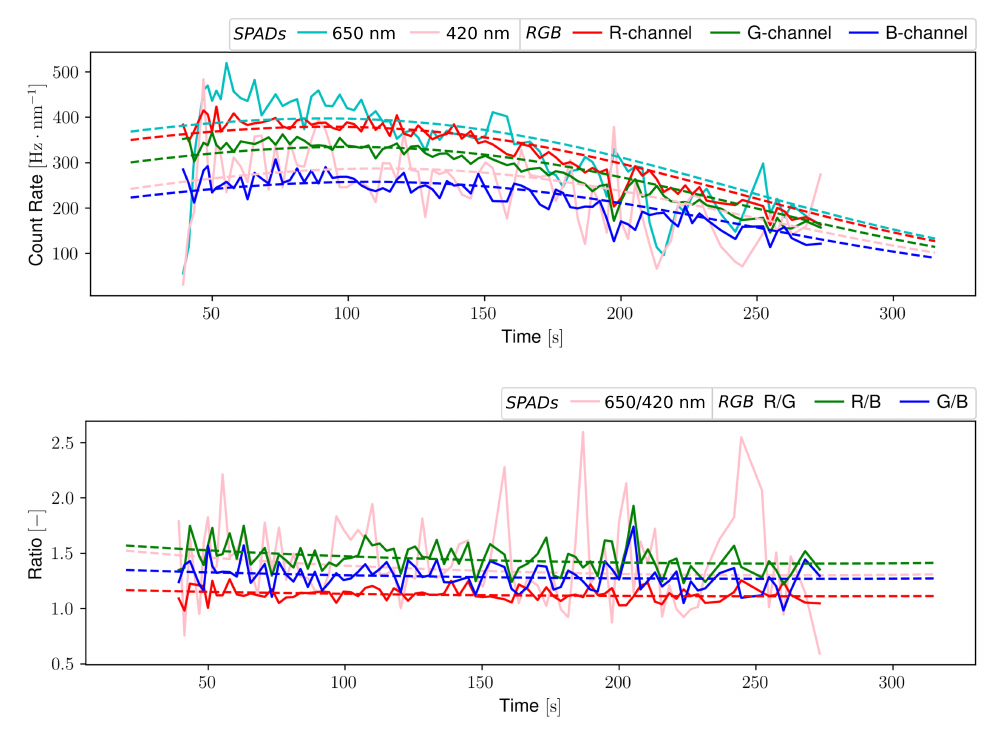
Figure 9. Comparison of simulated (dashed line) to measured (continuous line) data for a pass of Calsphere 4A on 25/11/2020. ( above ): count rates, ( below ): signal ratios.